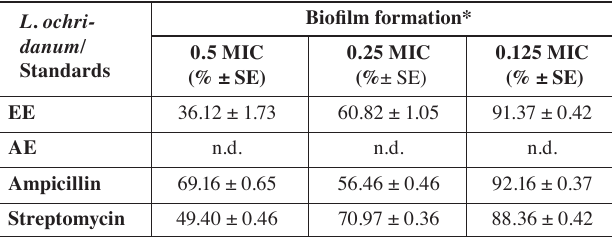
Tab. 5: Effects of L . ochridanum extracts on biofilm formation of P . aeru- ginosa PAO1 (%).